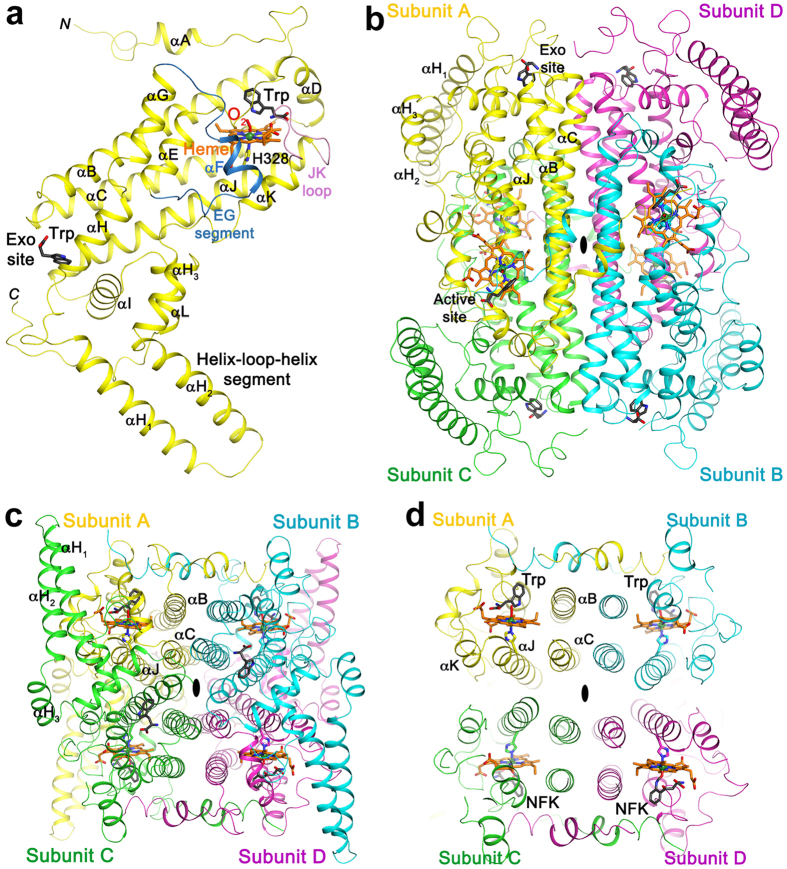
The structure of human TDO (hTDO).(a) Schematic representation of the structure of the hTDO monomer in a ternary complex with L-Trp and O2. Heme (in orange), L-Trp in the active site and the exo site (black), and oxygen (red) are shown as stick models. (b) Schematic representation of the hTDO tetramer, viewed down the two-fold axis (black oval) relating subunits A and B. The four subunits (A, B, C, and D) are colored in yellow, cyan, green and magenta, respectively. (c) Schematic representation of the hTDO tetramer viewed down the two-fold axis (black oval) relating subunits A and D. (d) A thin section of the structure of the hTDO tetramer, centered around the four hemes in the active sites, showing the three helices in each subunit that are in the tetramer interface. All structure figures were produced with the program PyMOL (www.pymol.org).